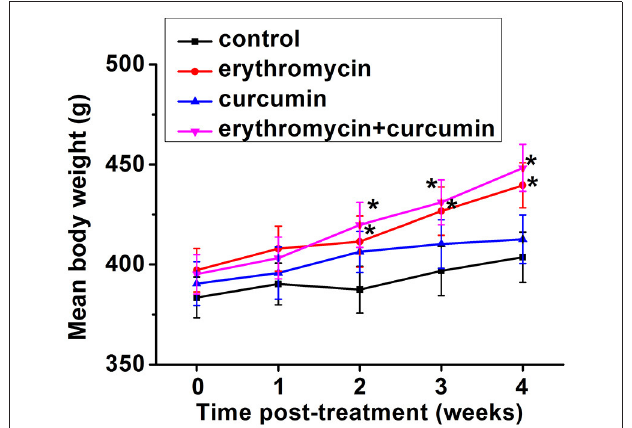
FIGURE 1 | Mean body weight in each experimental group at indicated time points post treatment. Results were presented as mean ± SD * p < 0.05 vs.